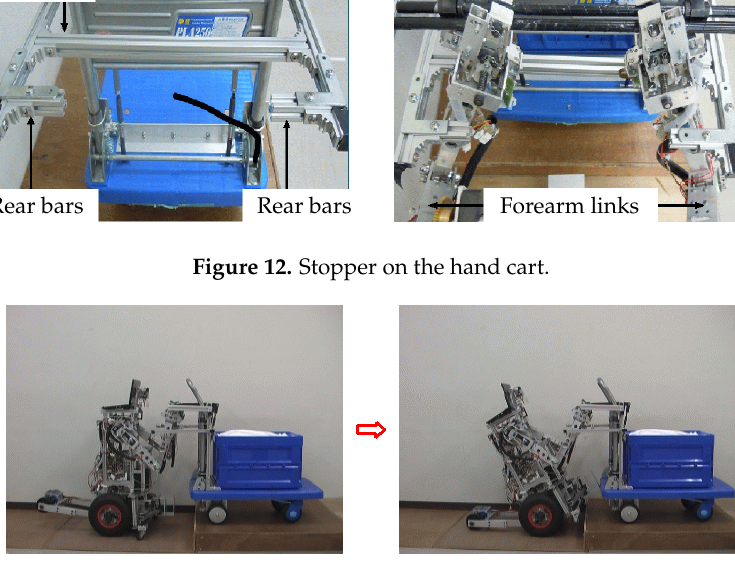
Figure 13. Robot lifting its front wheels